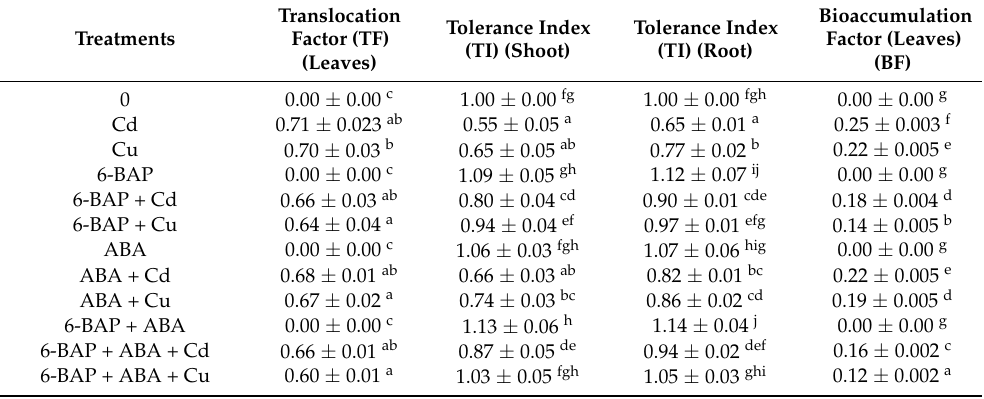
Table 7. Changes in the tolerance index of shoots and roots, translocation factor, and bioaccumulation factor in response to 10 µ M 6-BAP + 10 µ M ABA in combined or single forms when exposed to 100 µ M cadmium and 100 µ M copper, as compared to the control treatment. Each data point is the mean ± standard error for four repetitions. In this table, a, b, c, etc. letters revealed significant differences between treatments based on Tukey’s test ( p <